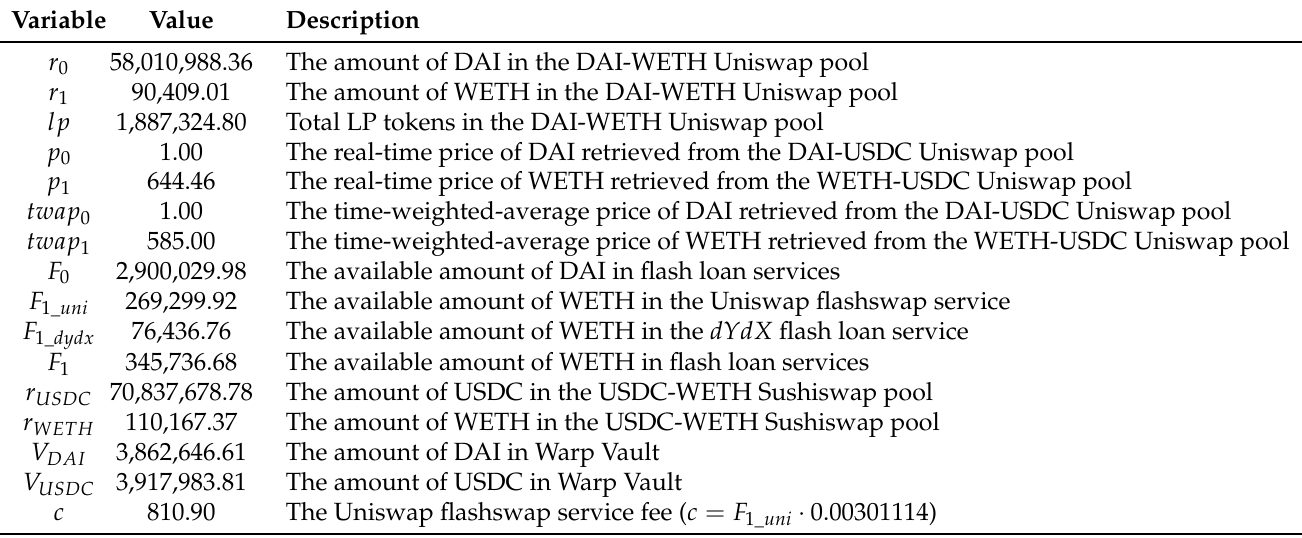
Table 1. States of Ethereum blockchain number 11,473,329 (just before the attack).